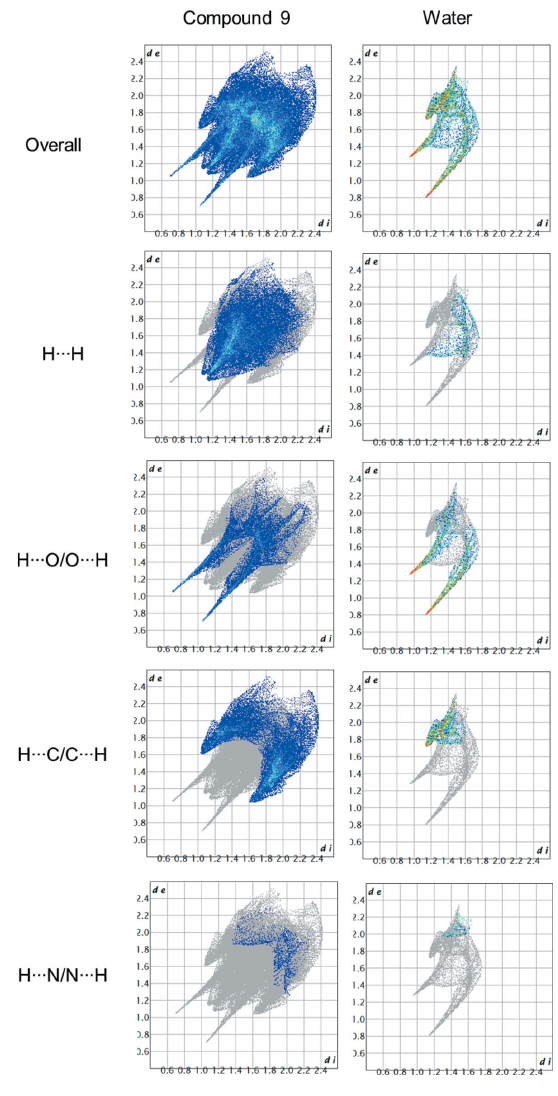
Figure 4 Overall two-dimensional fingerprint plots for compound 3HPPP and the water molecule together with those delineated into H (cid:2)(cid:2)(cid:2) H, H (cid:2)(cid:2)(cid:2) O/O (cid:2)(cid:2)(cid:2) H, H (cid:2)(cid:2)(cid:2) C/C (cid:2)(cid:2)(cid:2) H and H (cid:2)(cid:2)(cid:2) N/N (cid:2)(cid:2)(cid:2) H interactions, generated with Crystal Explorer (Spackman et al. ,